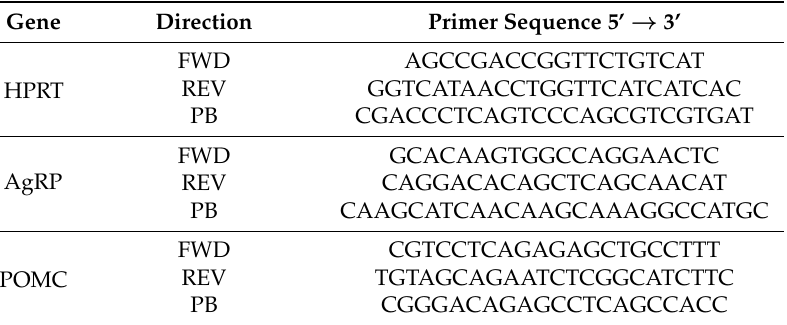
Table 1. Primers and probes used for gene